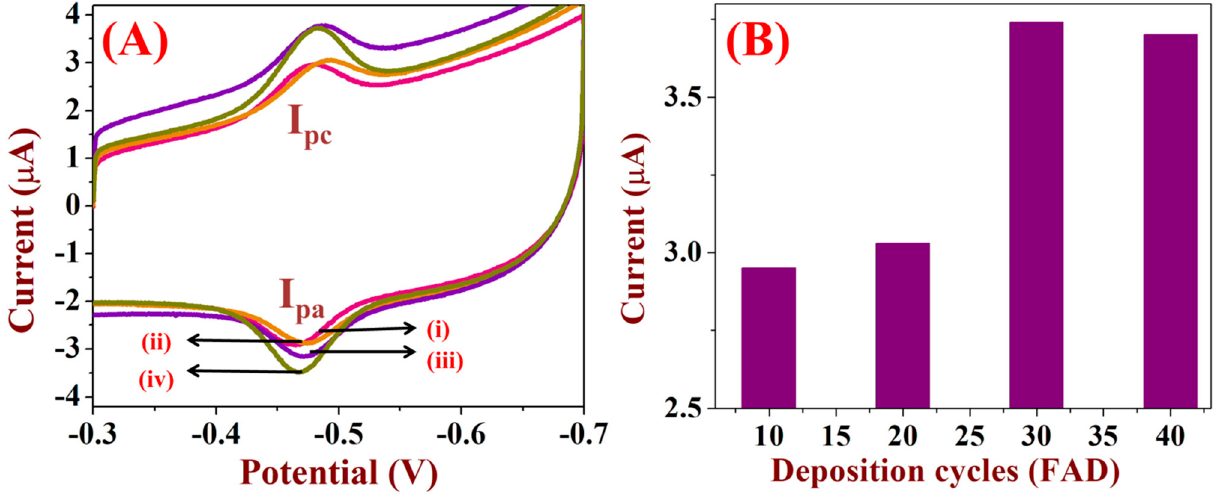
Figure 4. ( A ) CVs were recorded using Ti 3 C 2 T x /GCE after the FAD immobilization process by varying the number of potential cycles (i—10, ii—20, iii—30 and iv—40 cycles) in 0.1 M PBS, scan rate = 50 mV/s. ( B ) The bar diagram represents the relationship between the FAD deposition cycles and the reduction peak current of FAD/Ti 3 C 2 T x /GCE’s.